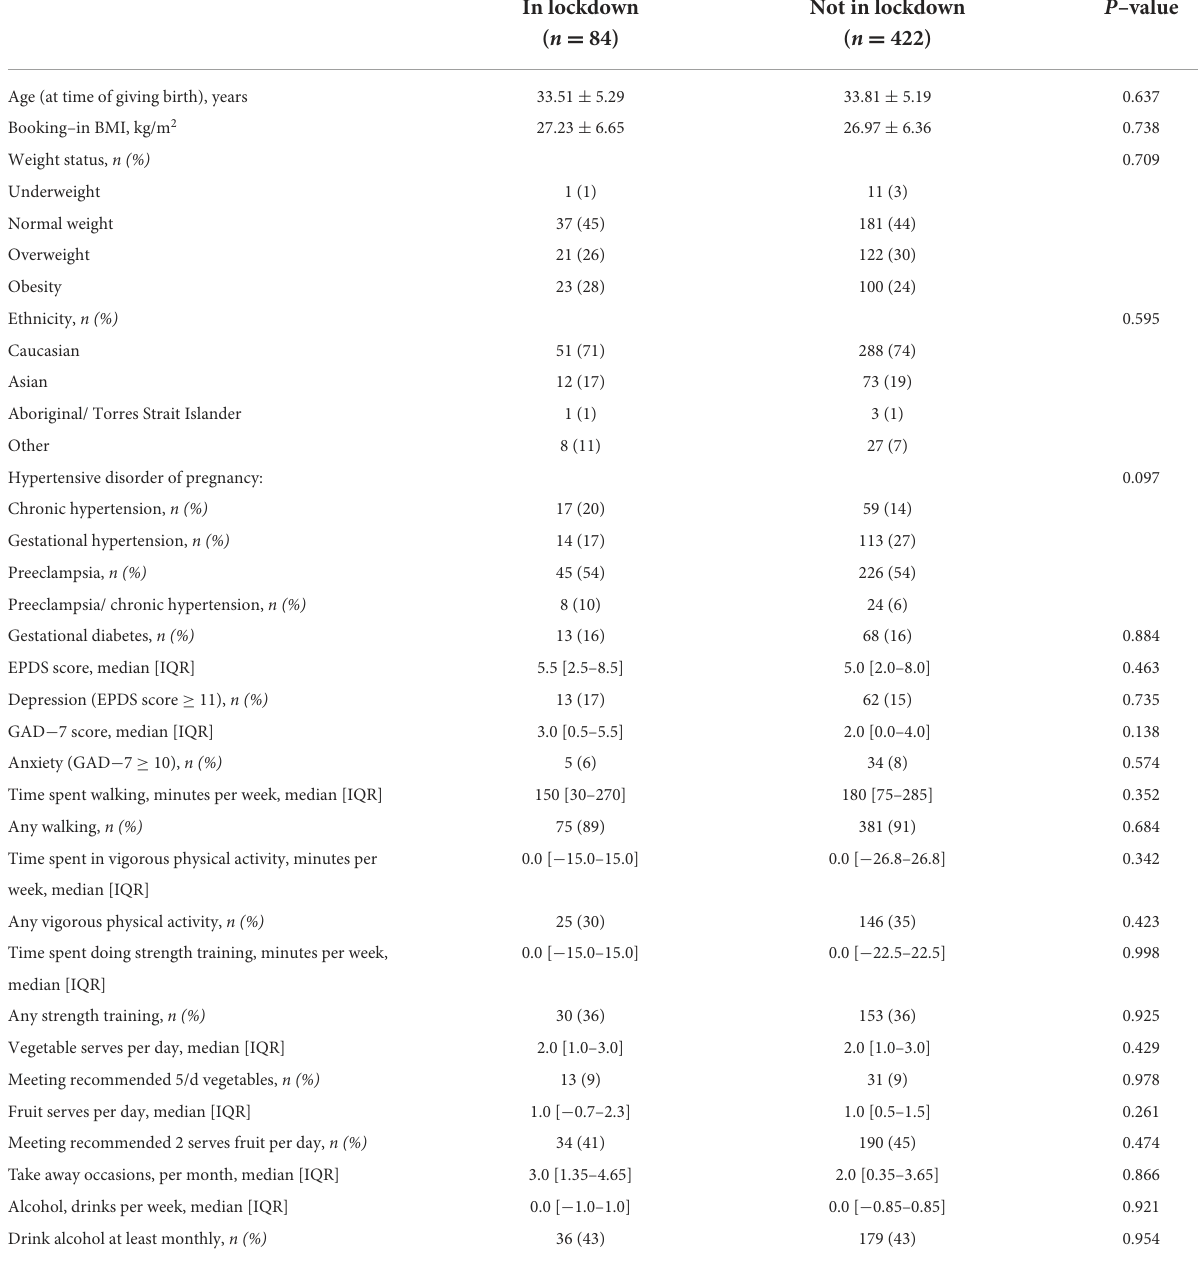
TABLE 1 Characteristics of women at 6-months postpartum participating in the BP 2 study who filled in study questionnaires during a COVID-19 lockdown vs. those not in a